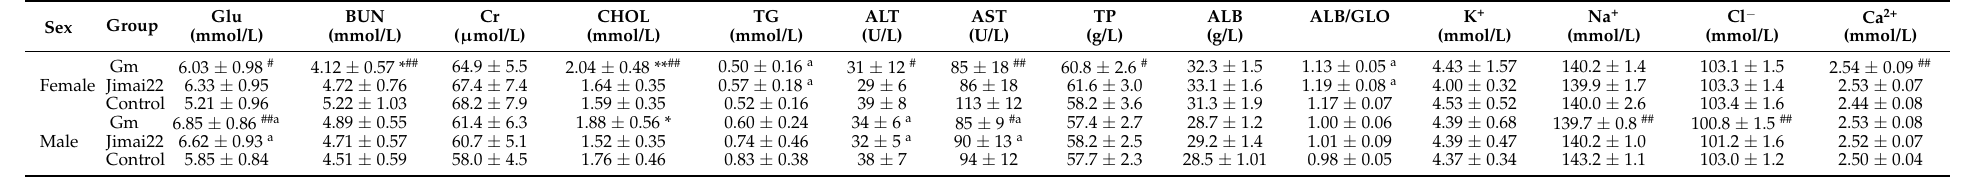
Table 2. Serum chemistry parameters of male and female rats ( x ± s, n =